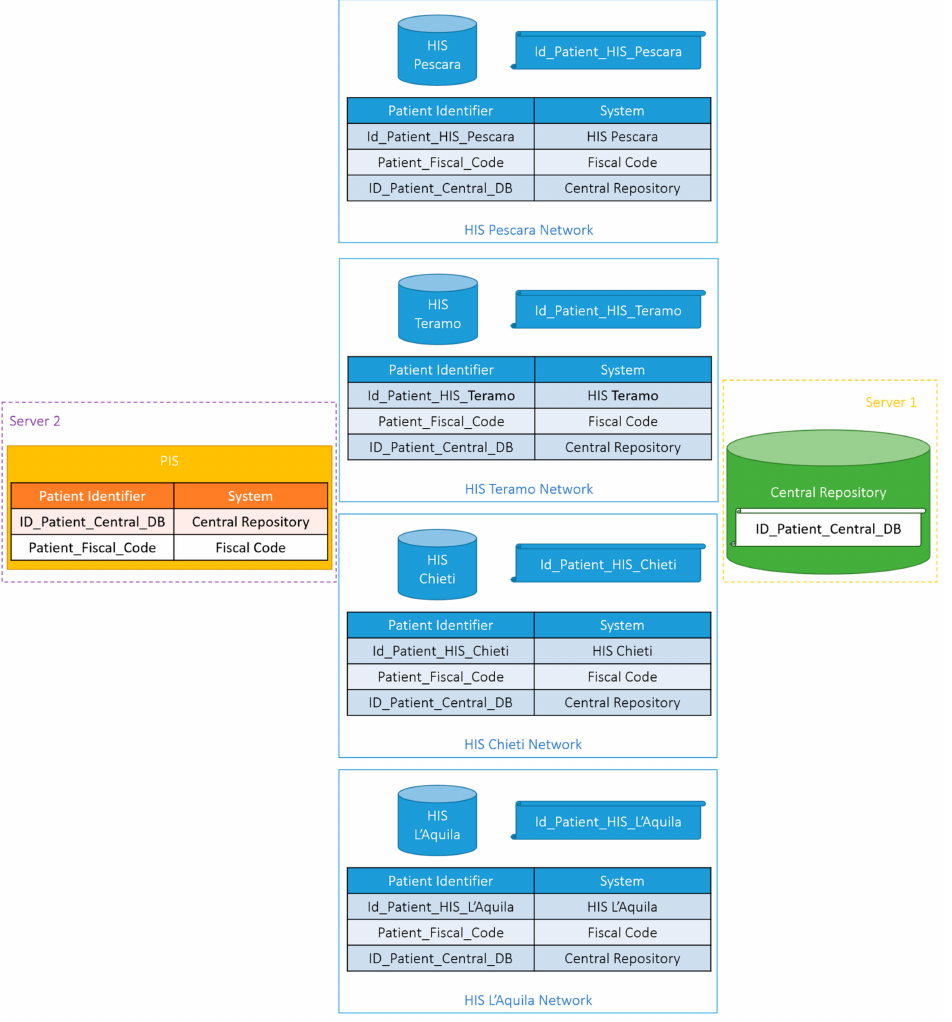
Figure 3. Patient’s identifier management to correctly pseudo-anonymize